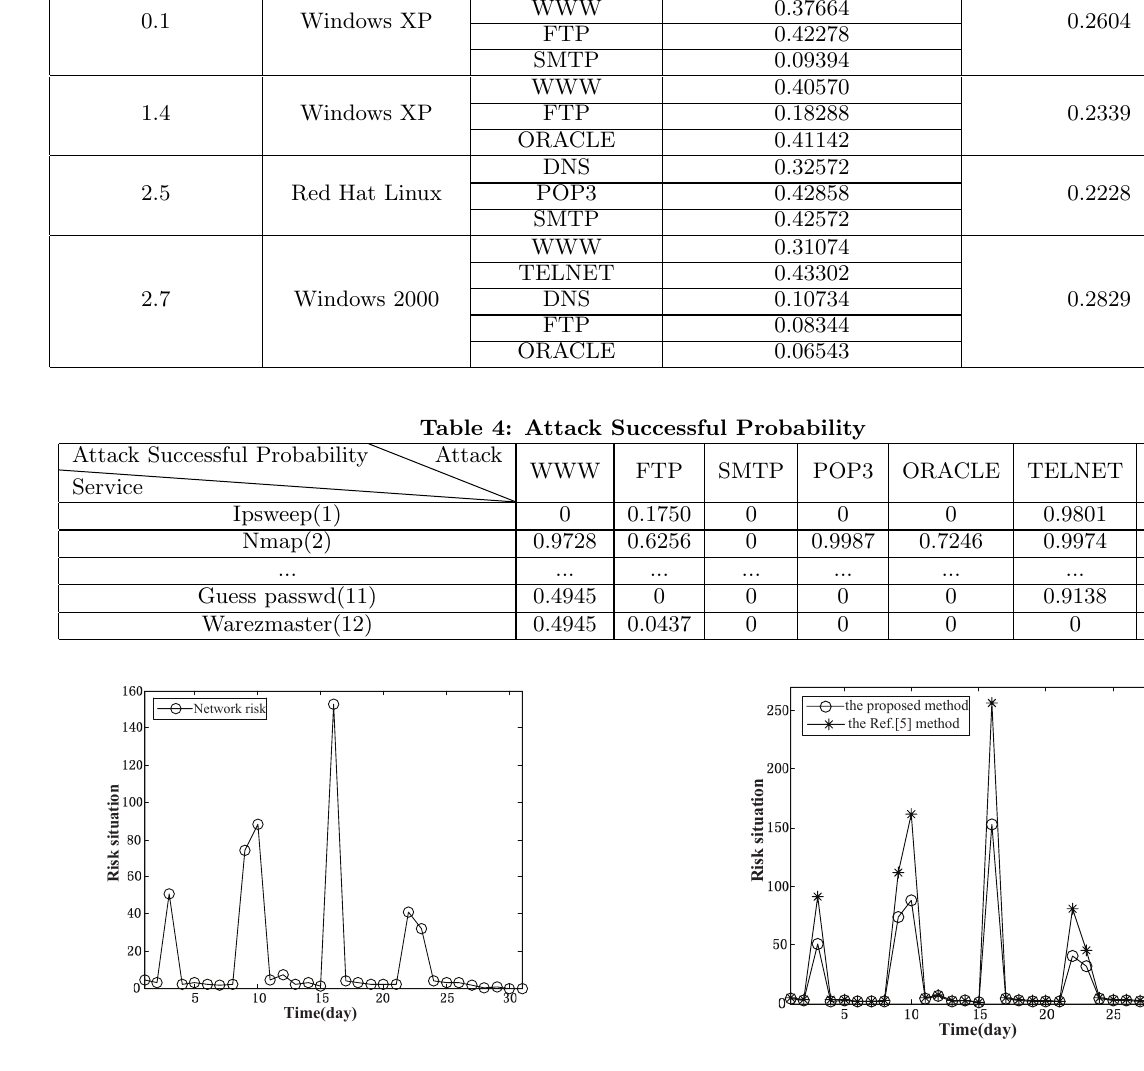
Figure 5: Risk of Network in Real Time